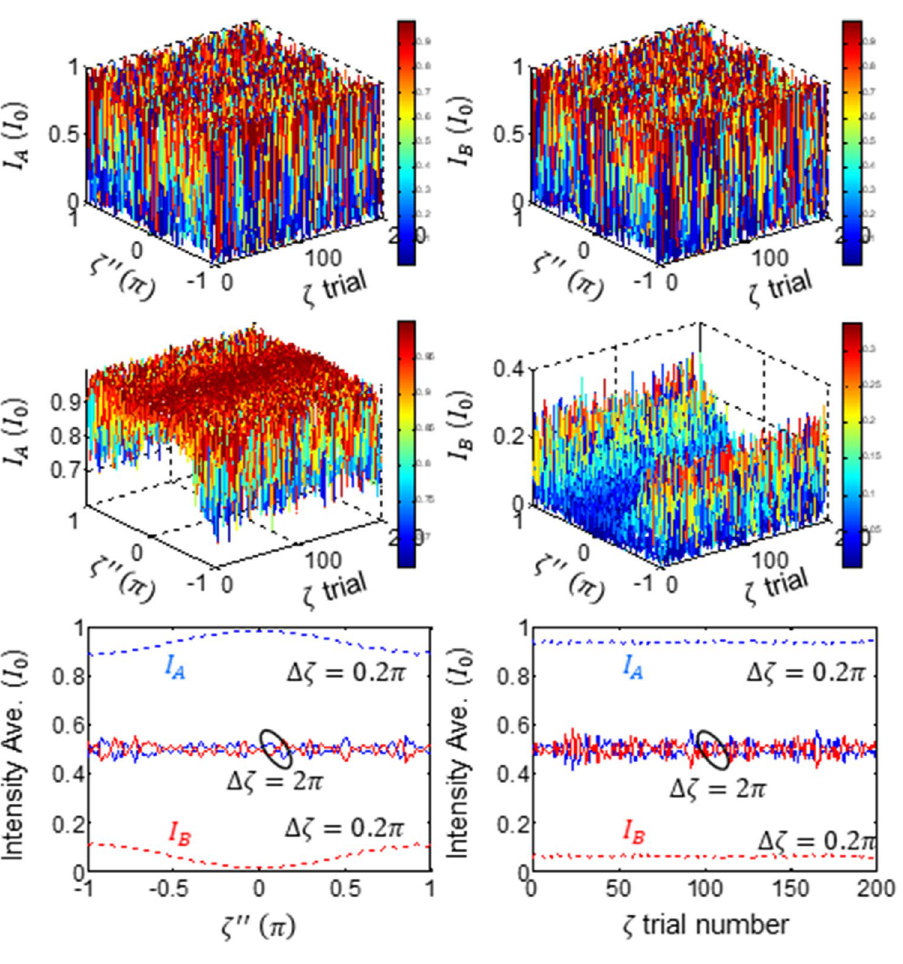
2 π . ζ ′ . (Upper panel) �ζ = = 2 π . �ζ = ≡ (cid:31)